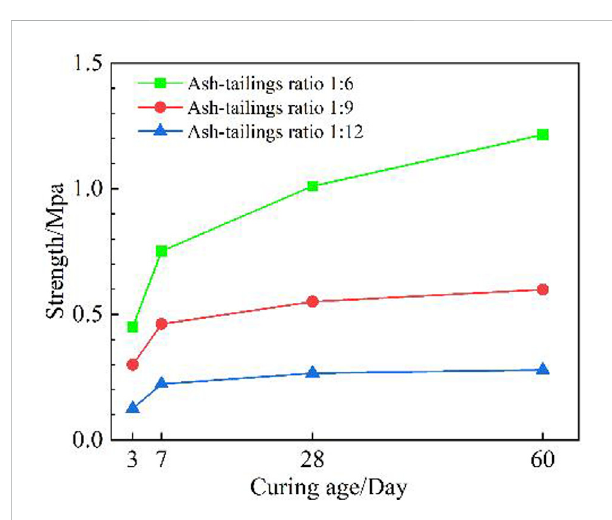
FIGURE 7 Variation of the strength of back fi ll materials for 49% concentration with the ash-tailings ratio.